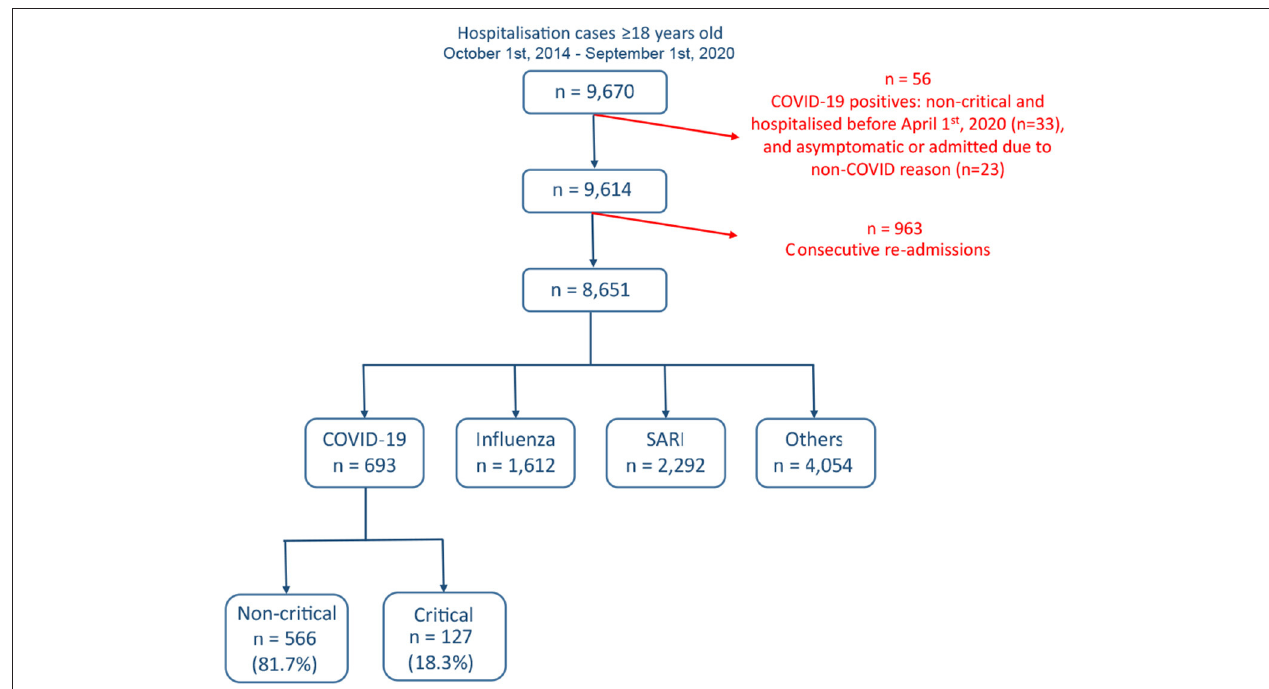
FIGURE 1 | Cohort selection and criteria for exclusion. Data from a total of 9,670 admitted cases were extracted from the Rambam Health Care Campus electronic medical records